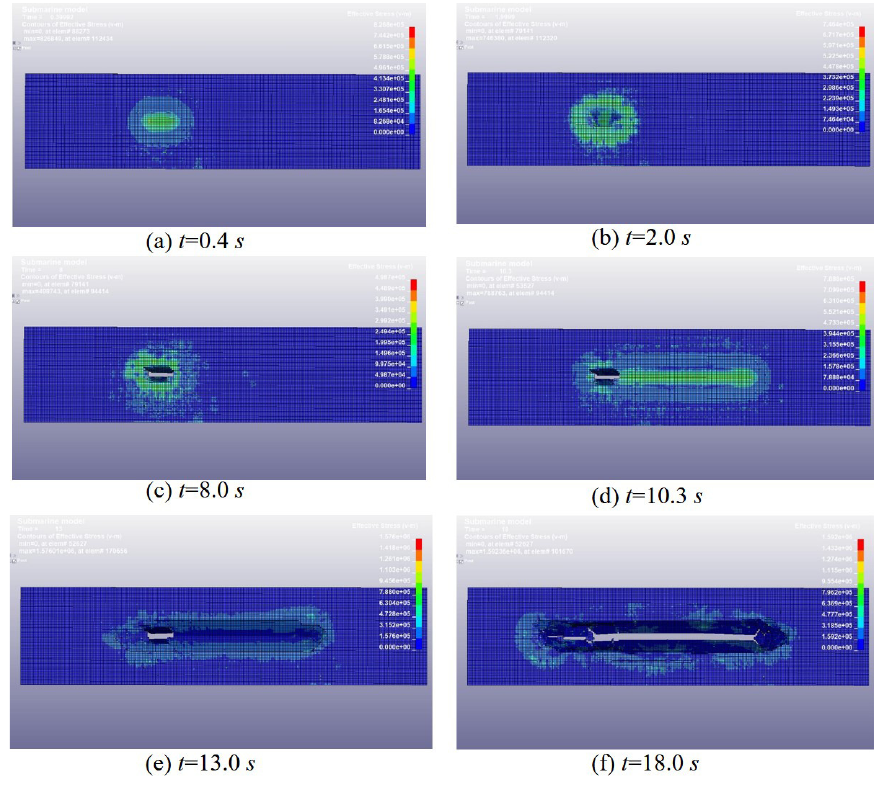
Figure 6. Distribution Map of von Mises equivalent stress in the ice sheet at different moments when the submarine is out of the water and crossing the